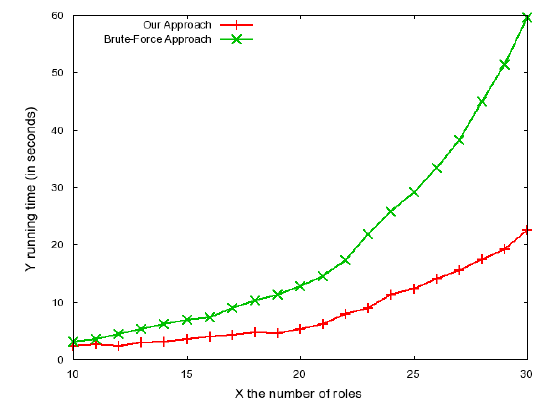
Fig. 2. CPU time for our approach and brute-force approach